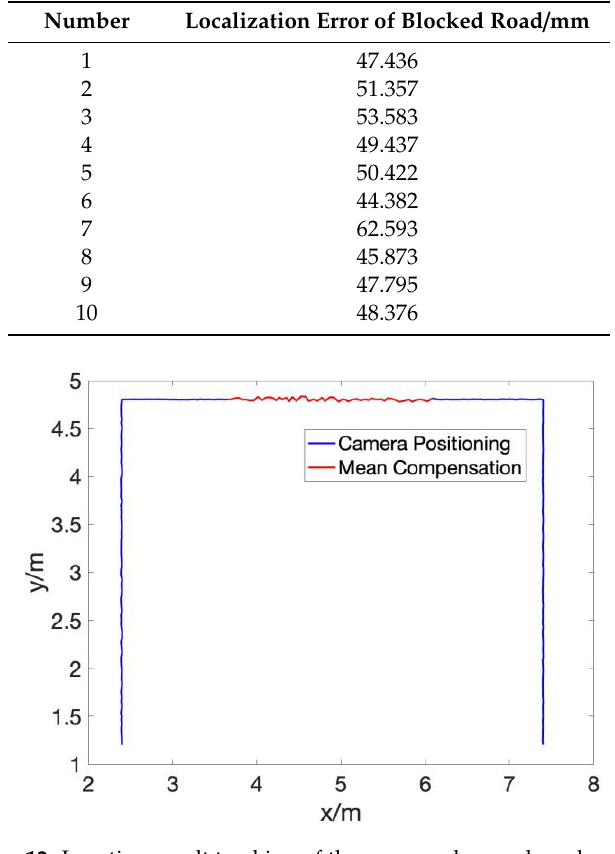
Figure 14. Results of three localization methods: ( a ) relative to the results of the localization of the entire path; ( b ) localization results relative to a path zoom. Table 4. The average errors of 10 fusion localization results on the blocked road. number